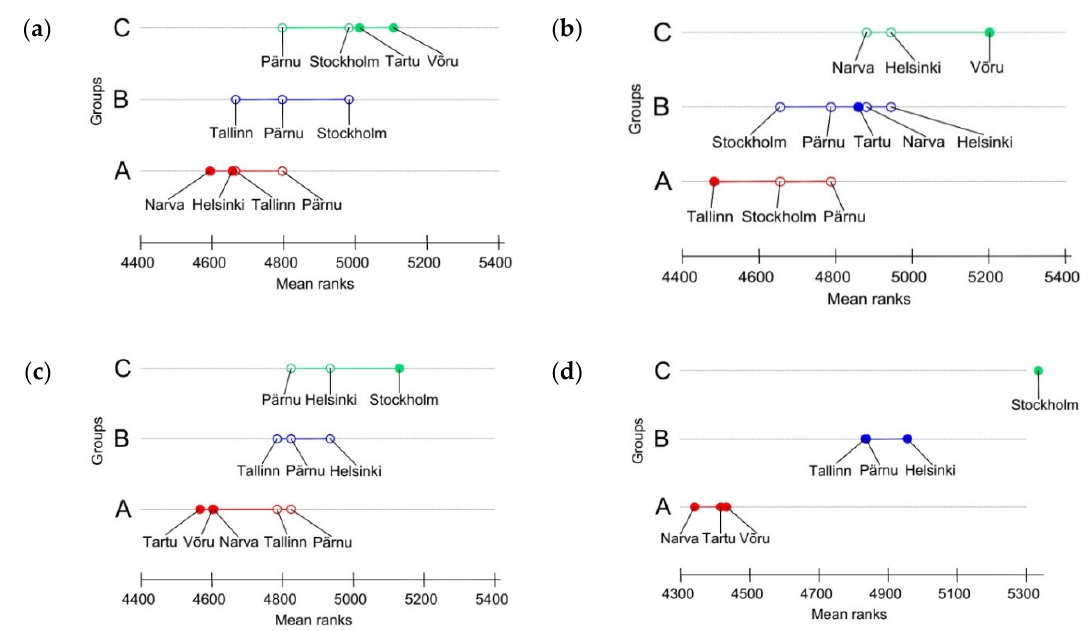
Figure 7. Division of the cities in the central Baltic area into groups on the basis of the critical difference in average daily surface air temperatures according to the Dunn’s test: ( a )—spring, ( b )—summer, ( c )—autumn, and ( d )—winter.